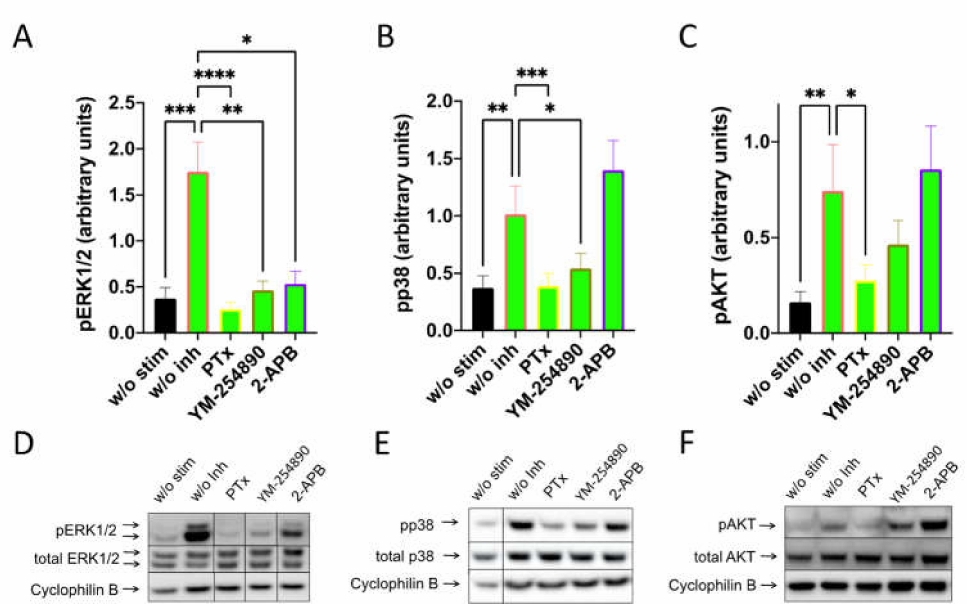
Figure 4. Interconnections between early and later signals induced by SP are comparable to those elicited by c48/80. MCs were pretreated with inhibitors, as shown in Figure 3, then stimulated with SP (30 µ M) for 1 min. ( A – C ) Signals of pERK1/2, pp38 and pAKT were quantified and normalized to cyclophilin B as described in methods. ( D – F ) Representative blots of A–C. Data shown are Mean ± SEM of 11–13 independent experiments. * p < 0.05, ** p < 0.01, *** p < 0.001, **** p <